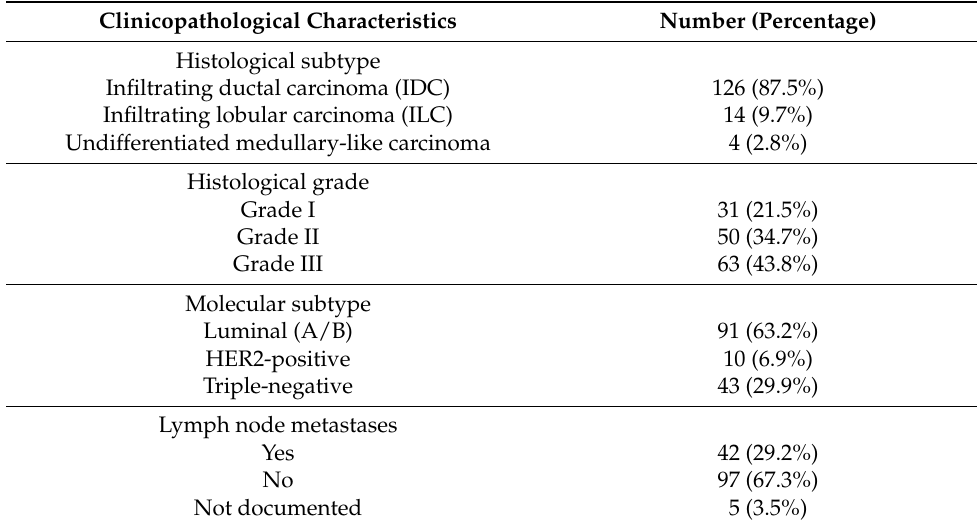
Table 2. The clinicopathological characteristics of 144 breast cancer